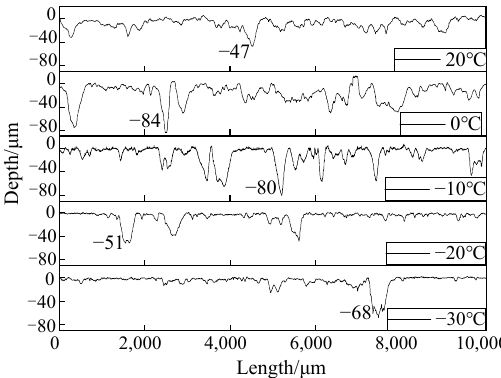
Figure 17. Surface profile of the brake disc braking material.